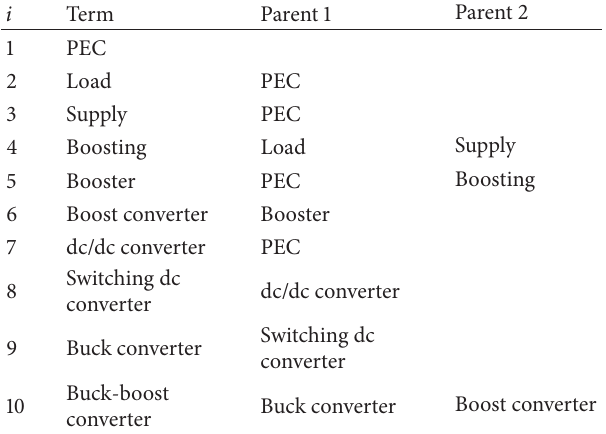
Table 1: Fragment of the concept table in Power